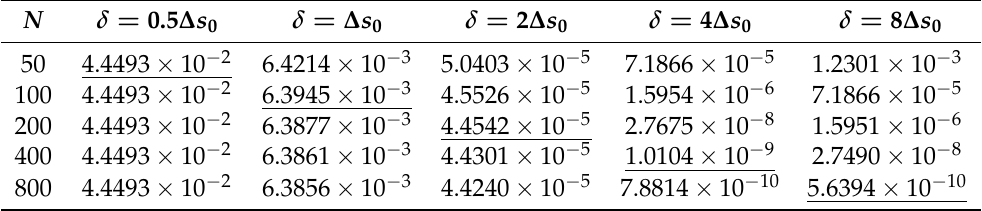
Table 3. Errors in the circle radius in example 2 using the blob ψ δ . The errors were computed as max t | R ( t ) − R exact ( t ) | . The initial arc length discretization is defined as ∆ s 0 = 2 π R 0 / N . The underlined values correspond to errors for a fixed value of δ